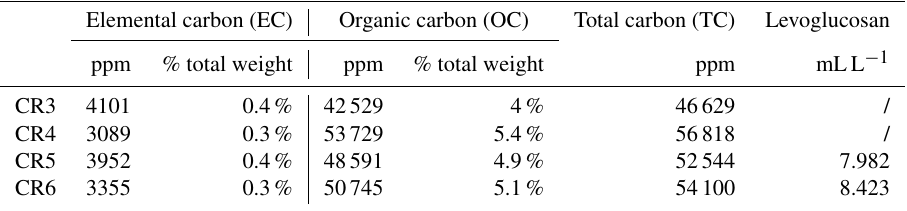
Figure 7. (a, b, c) Maps of α VIS , I imp and SDI obtained from Hyperion reflectance for the classes snow and bare ice in the Bernina Range. (d) RGB composition created by combining SDI, α VIS and I imp respectively in the R, G and B channels. (e, f, g) Normalized frequency of α VIS , I imp and SDI for the classes snow (red bars) and ice (blue bars). Table 2. Summary of elemental carbon (EC), organic carbon (OC), total carbon (TC) and levoglucosan concentrations in cryoconite samples